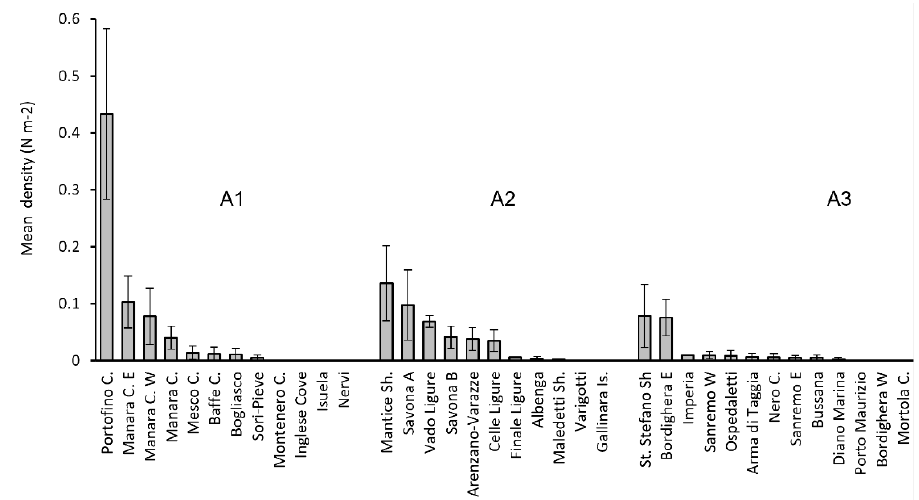
Figure 2. ( a ) Distribution of Astrospartus mediterraneus in the Mediterranean Sea and Atlantic waters. Red circles, scientific papers; white spots, citizen science observations; red stars, presence without indication of geographic coordinates. ( b ) Map of the Ligurian Sea with indicated the studied sites in the three macro-areas (A1, Eastern Liguria; A2, Central Liguria; A3, Western Liguria). ( c – e ) En- largements of the three macro-areas. Red circles are sites with A. mediterraneus (the size of the circle is proportional to the density of the specimens); white circles are sites without recorded specimens.